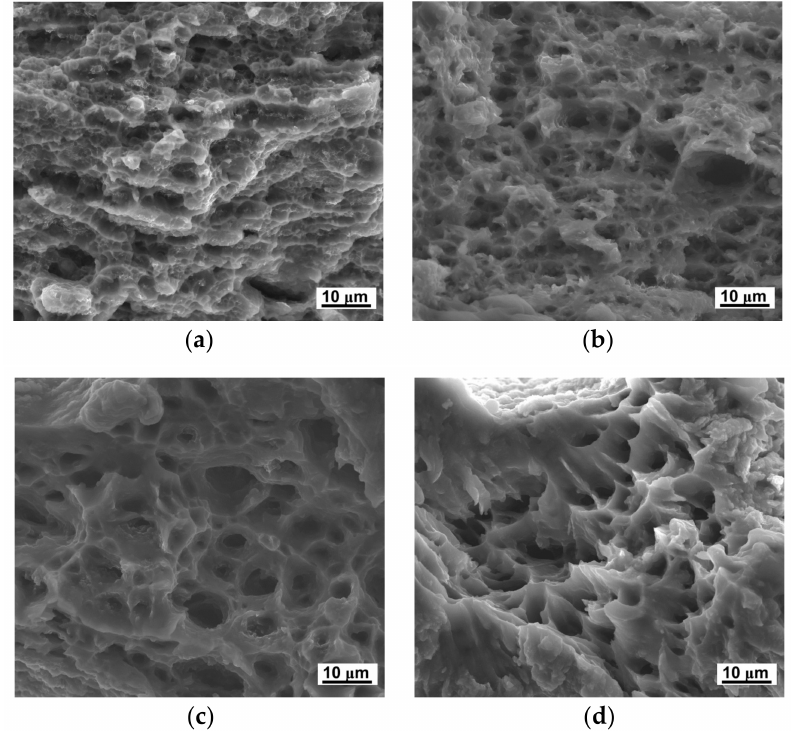
Figure 11. Micro-tensile fracture morphology of the LZ91 alloy processed by HPT through 10 turns at temperatures of ( a ) 298 K; ( b ) 373 K; ( c ) 423 K; and ( d ) 473